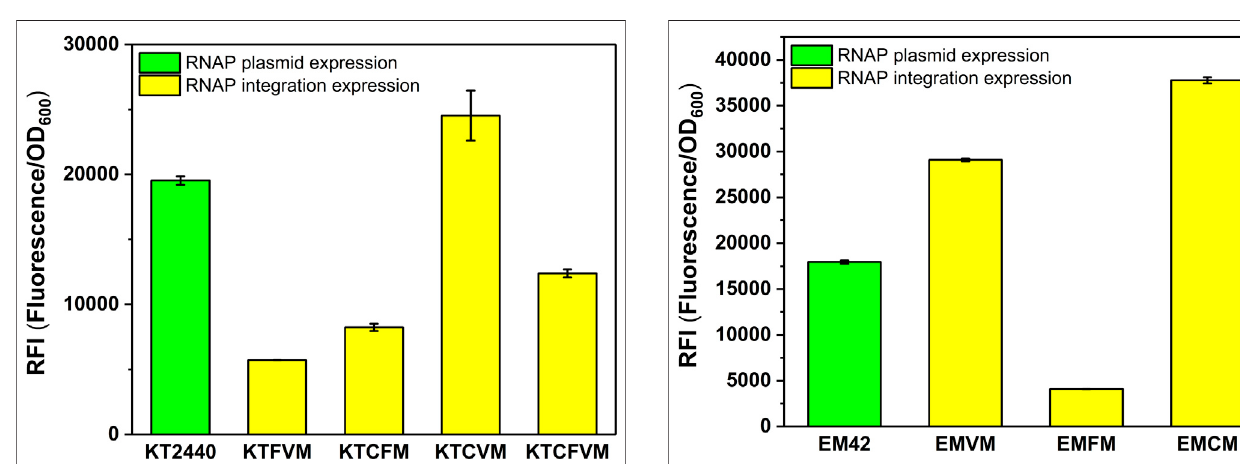
FIGURE 4 | RFI of the MmP1 RNAP cassette integrated into P. putida EM42 with different integration sites. EM42: EM42 harboring the plasmid containingtheMmP1RNAPmoduleandsfGFPwithMmP1promoter;EMVM: EMVMwithinsertionsitesof vdh harboringtheplasmidcontainingsfGFP withMmP1promoter;EMFM:EMFMwithinsertionsitesof phaF harboringthe plasmidcontainingsfGFPwithMmP1promoter;EMCM:EMCMwithinsertion sites of phaC1 harboring the plasmid containing sfGFP with MmP1 promoter.